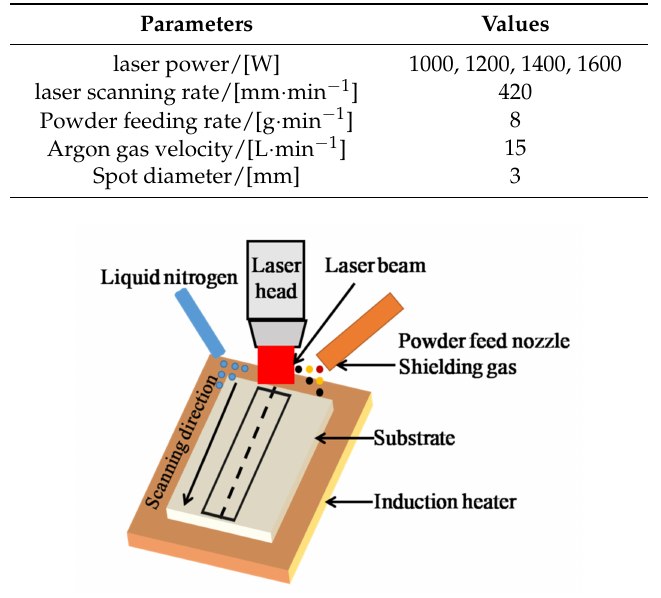
Table 2. Laser cladding process parameters.